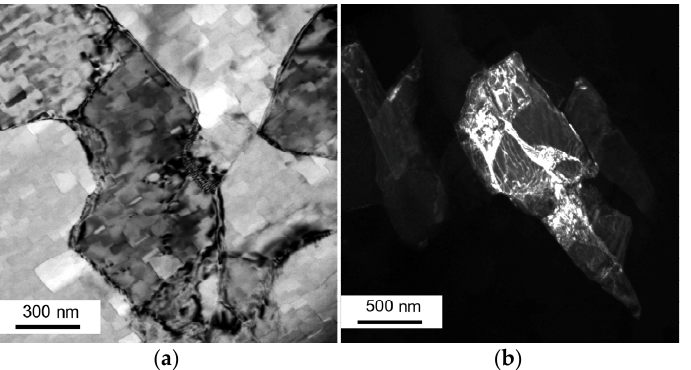
Figure 9. Dislocation structure of SMC AlGr composite after DCAP: bright-field image ( a ) and dark-field image in (111) Al reflection ( b ). Table 2. Characteristics of the fine-structured composites.